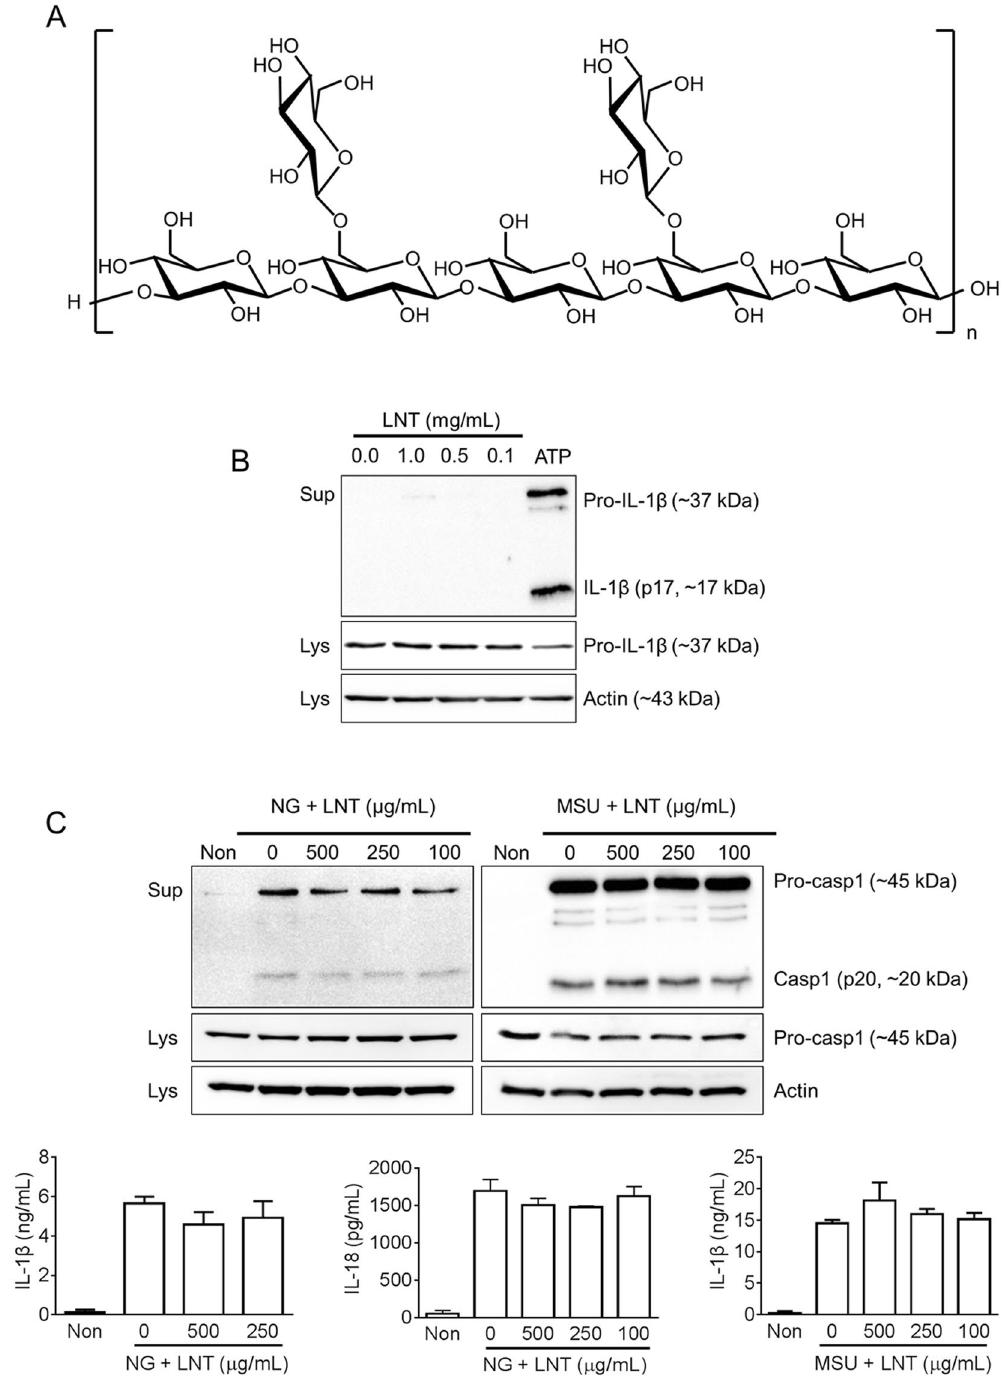
Figure 1. Effect of lentinan on NLRP3 inflammasome activation. ( A ) Chemical structure of lentinan (LNT). ( B ) Lipopolysaccharide-primed bone marrow-derived macrophages (LPS-primed BMDMs) were treated with the indicated concentration of LNT or ATP (2 mM) as a positive control. Secretion of active form of IL-1 β was analyzed by immunoblotting. ( C ) LPS-primed BMDMs were treated with the indicated dosage of LNT with/without nigericin (NG, 40 μ M) or monosodium urate crystals (MSU, 800 μ g/mL). Secretion of caspase-1 (Casp1) was analyzed by immunoblotting, and IL-1 β or IL-18 secretion was measured by ELISA. All immunoblot data shown are representative of at least three independent experiments. Bar graph presents the mean ±